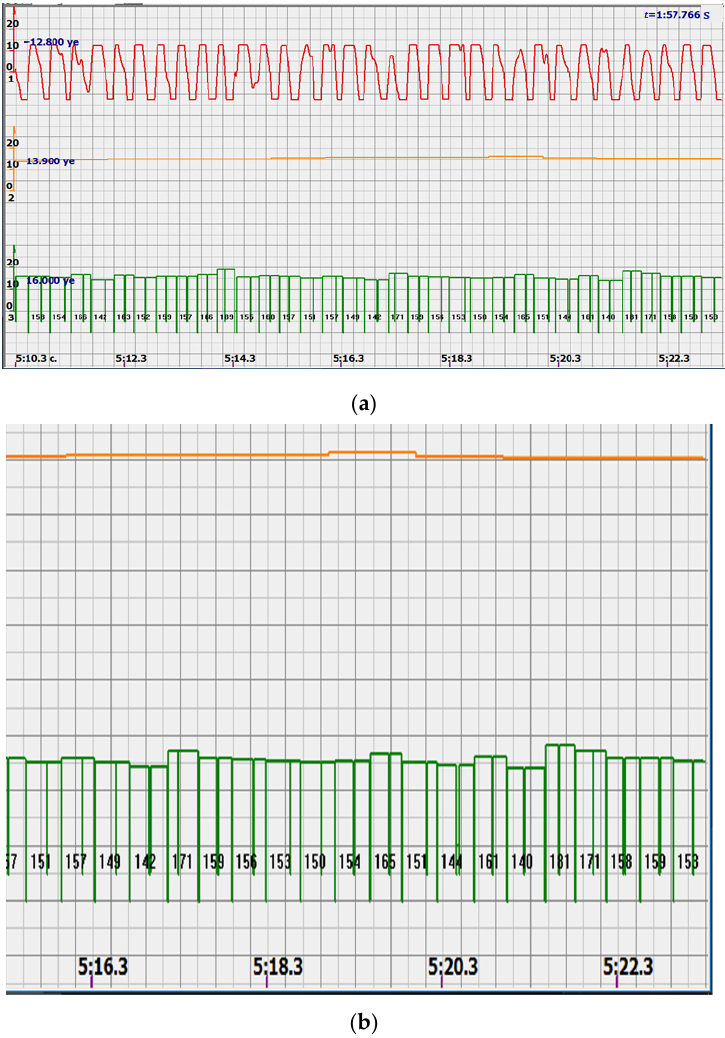
Figure 9. 12 s interval of CTG ( a ), in which there were no dips or incorrect signals and the diagram of the fetal heart rate, calculated from the null values of the ultrasound signal ( b ), on an enhanced scale, along the ordinate axis, and in numbers: heart rate in beats in a minute.